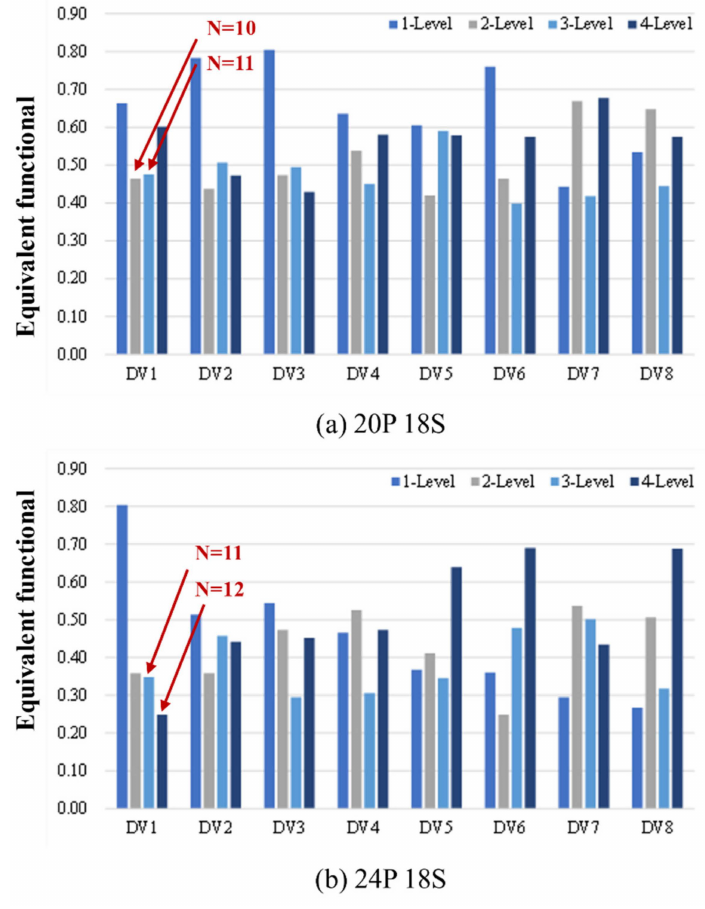
Figure 18. What-if design mean value